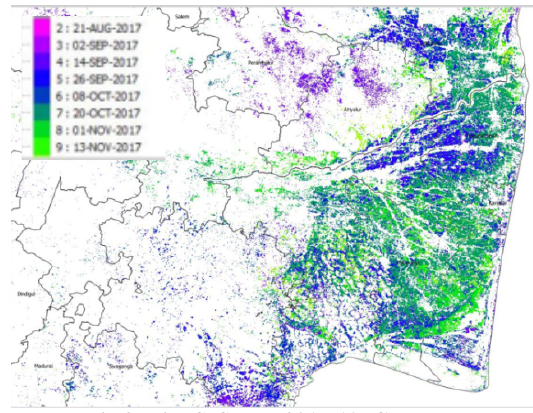
Fig.2. Rice SoS map 2017-18- Cauvery Delta Table 2. District wise rice area statistics (ha) at 12